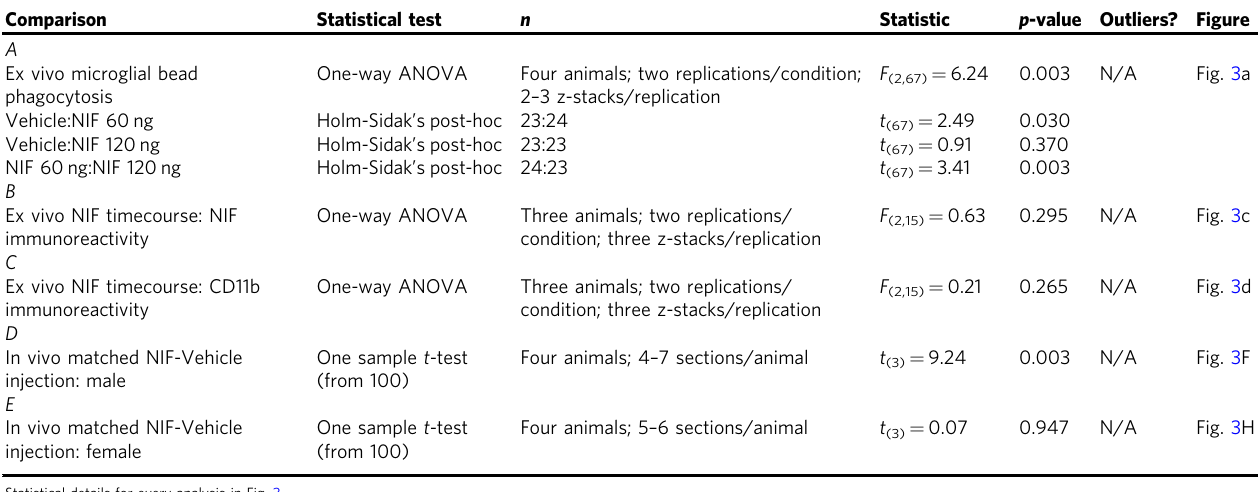
Table 3 Detailed statistics corresponding with Fig.